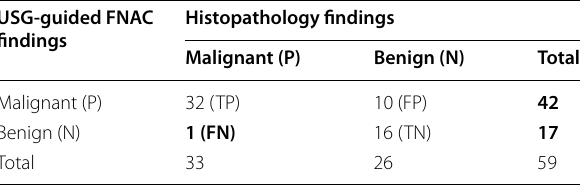
Table 4 Risk of malignancy in each category found in our 59) =